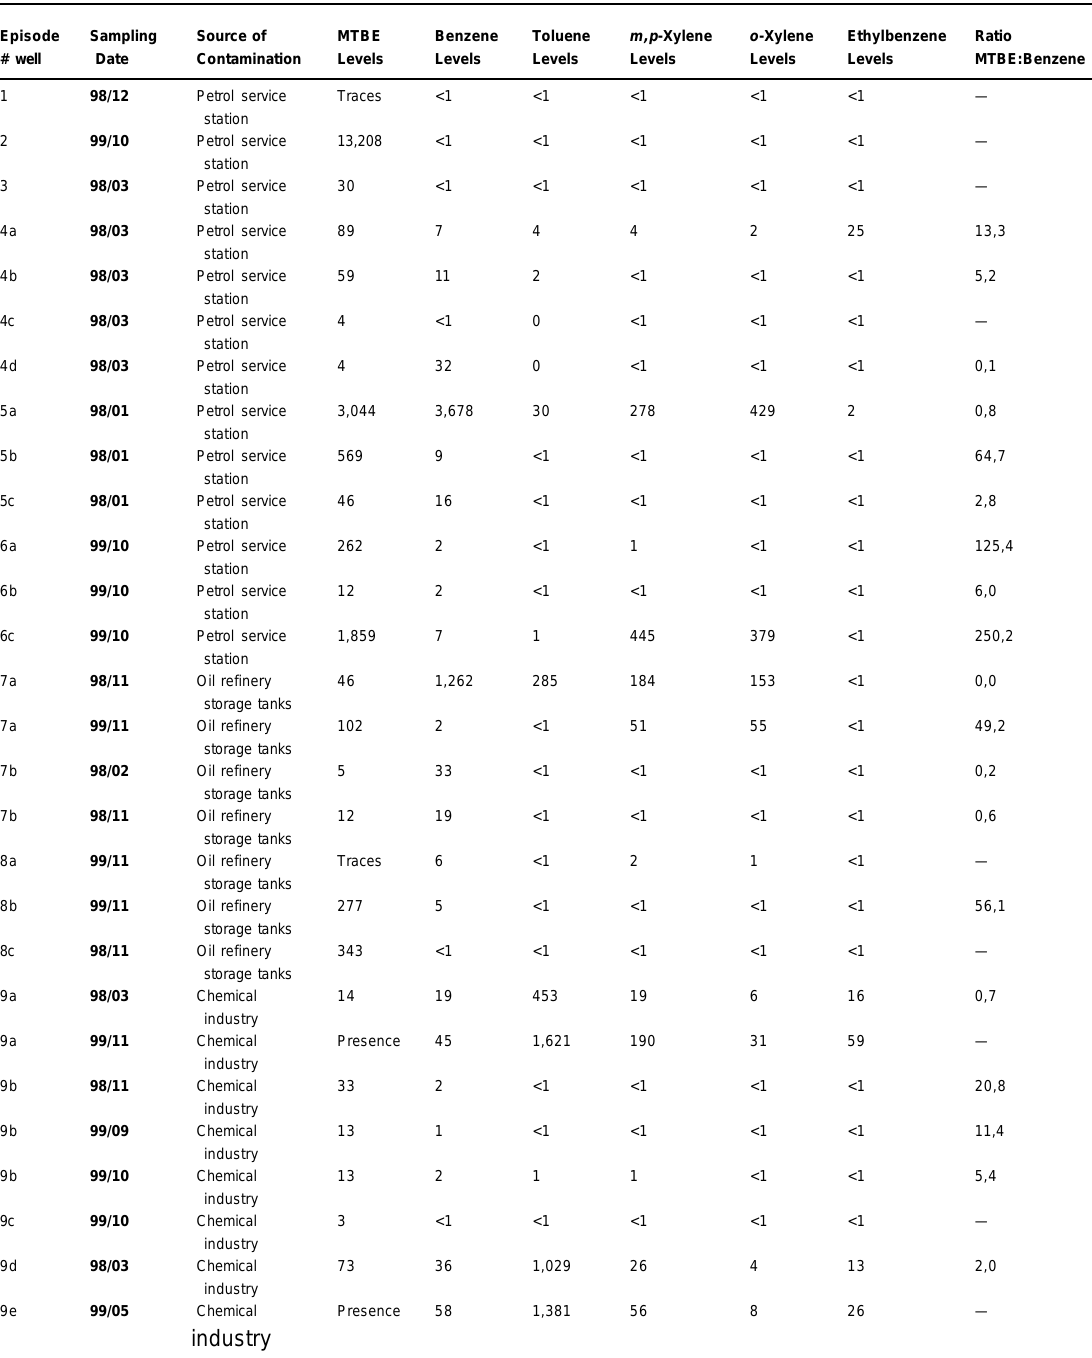
Levels of MTBE and BTEX Expressed in µg/l of selected “Hot Spots” in Catalonia (Northeast of